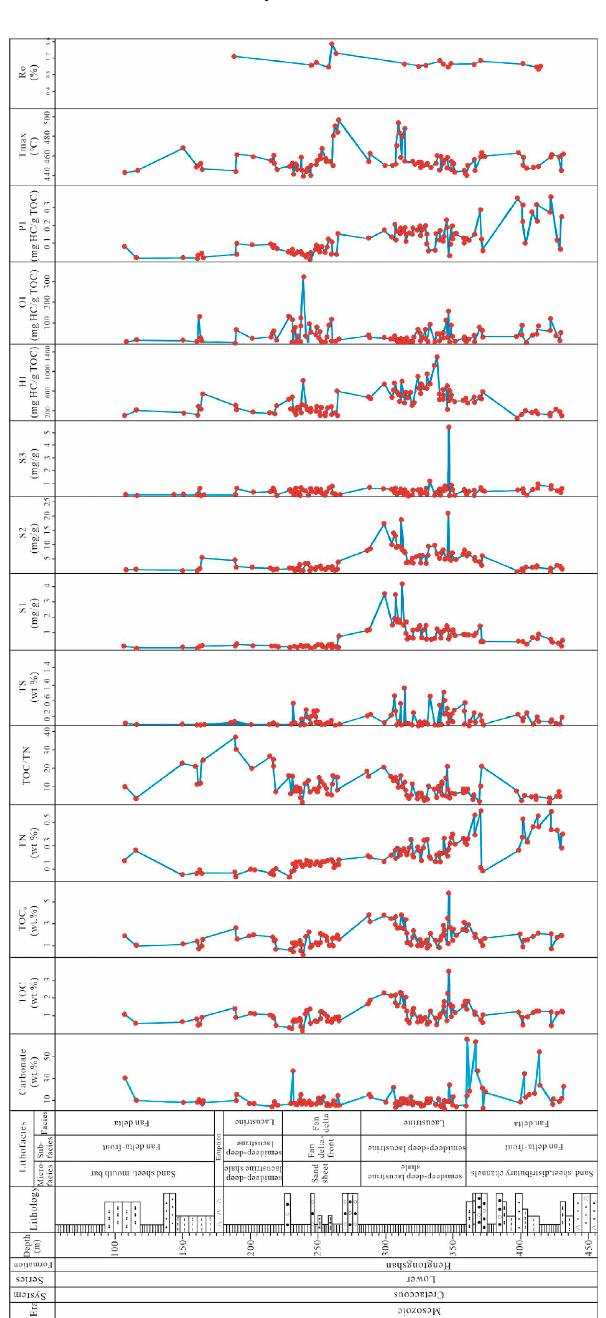
Figure 3. Map of the bulk geochemical parameters of the Hengtongshan Formation from drill